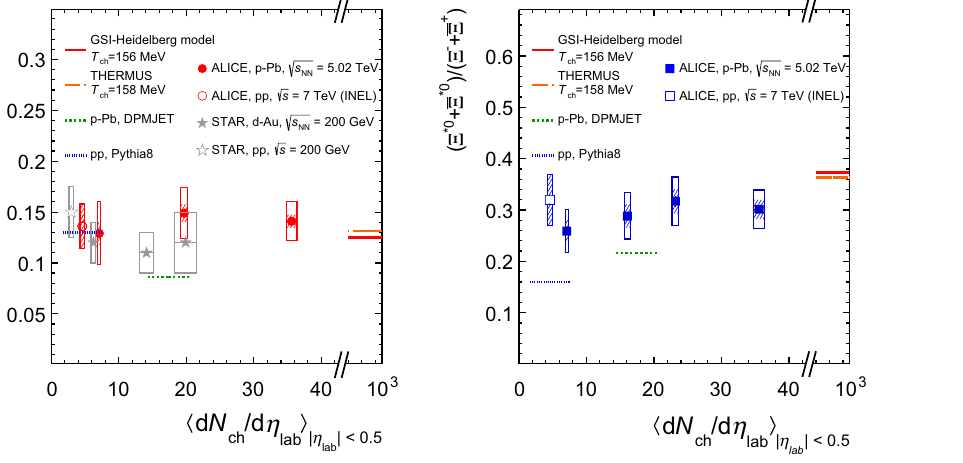
lowboxes )andsystematicuncertaintiesuncorrelatedacrossmultiplicity ( shaded boxes ). A few model predictions are also shown as lines at their appropriate abscissa